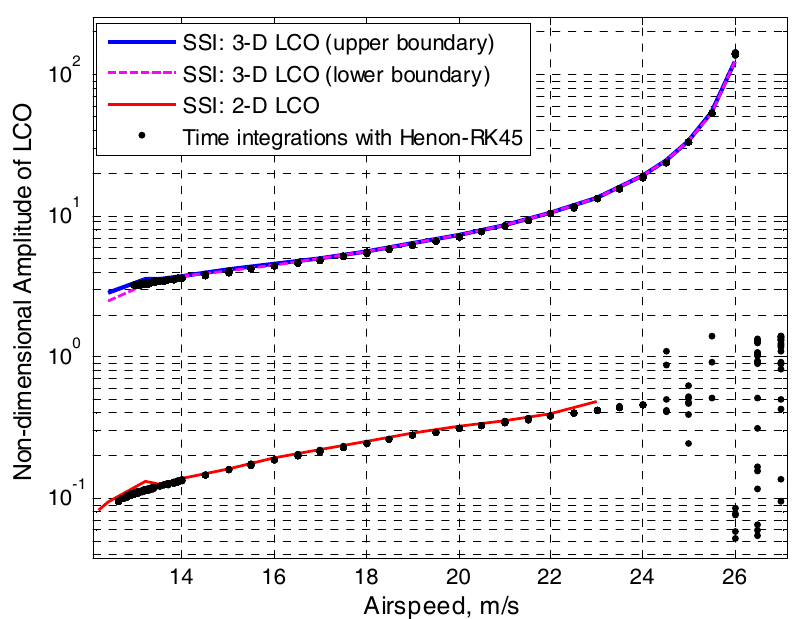
Figure 24. Comparison of LCO non-dimensional amplitudes varying with airspeed between the state space iterating (SSI) scheme and the time integrations with the Hénon–RK45 method.